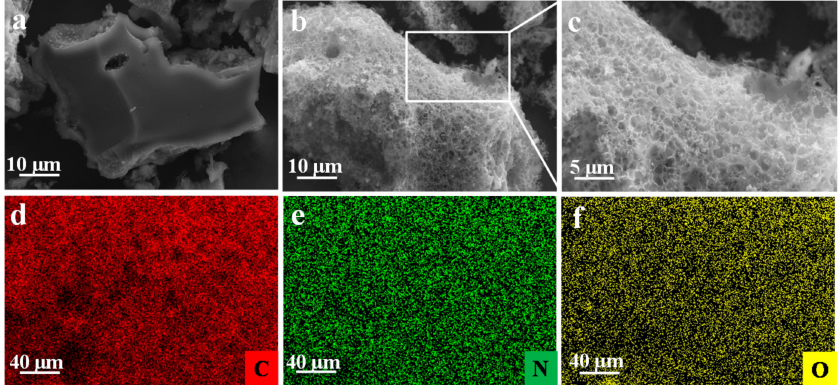
Figure 3. SEM images of CH-100 ( a ), NRPC-112 ( b , c ), and the corresponding EDX mapping of ( d ) C, ( e ) N, ( f ) O.